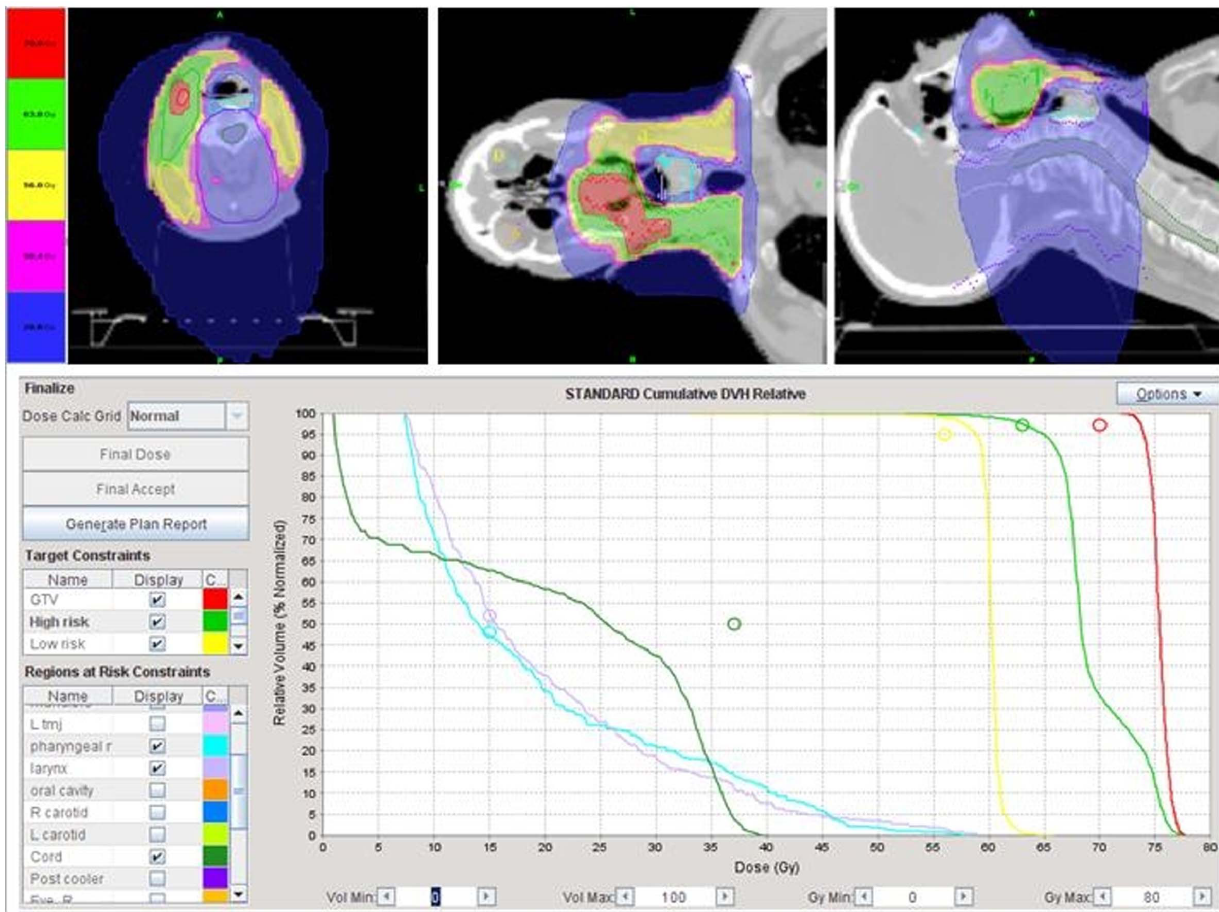
Figure 1. Illustration of the potential of Tomotherapy to spare the pharyngeal muscles in a patient with locally advanced base of tongue cancer and right neck nodal metastases treated with definitive concurrent chemoradiation. Despite the proximity of the gross tumor and neck nodes treated to 70 Gy, mean pharyngeal muscle radiation dose was 22.5 Gy. A split field intensity-modulated radiotherapy technique to shield the larynx and pharyngeal muscles would have underdosed the right neck nodes and gross tumor. The patient is in clinical remission two years following treatment and has no difficulty with swallowing except for xerostomia as the parotid gland could not be spared.